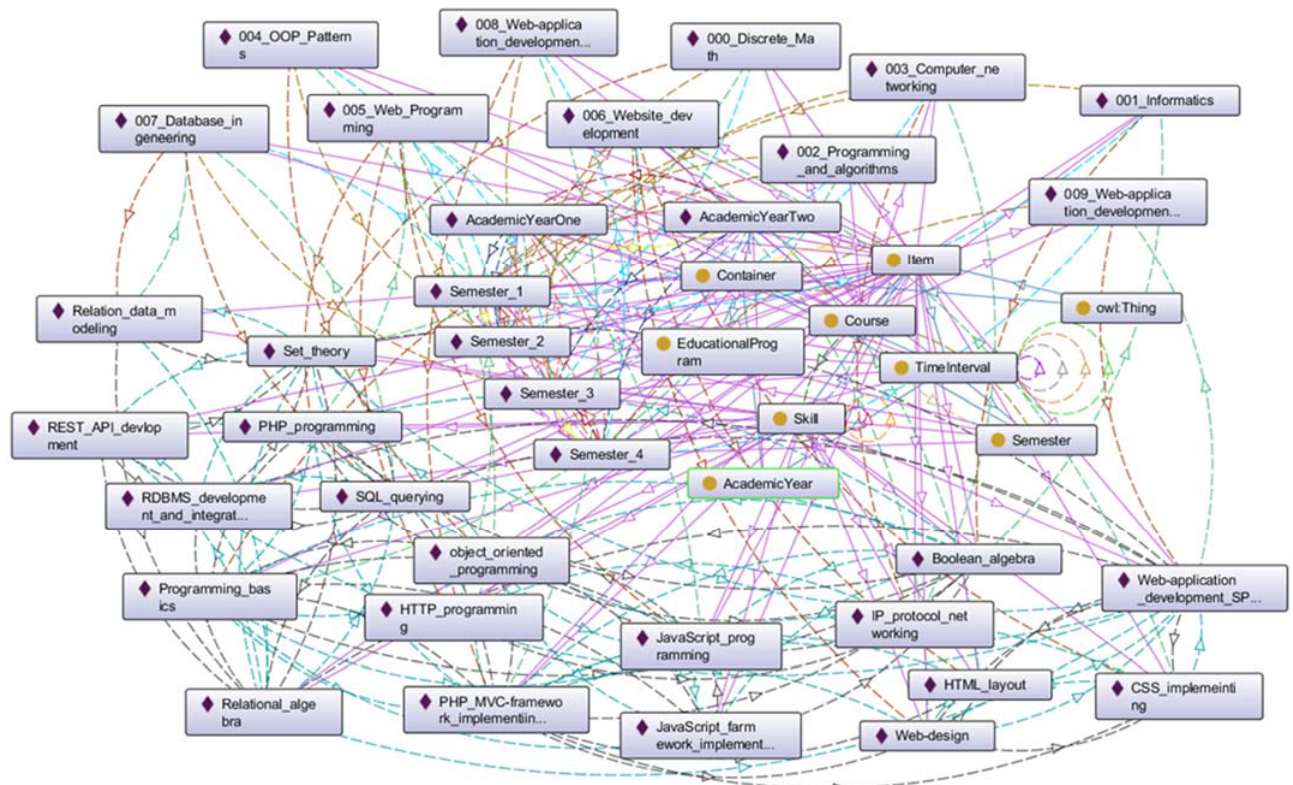
Figure 9. The complete graph of the ontology of the educational programme.